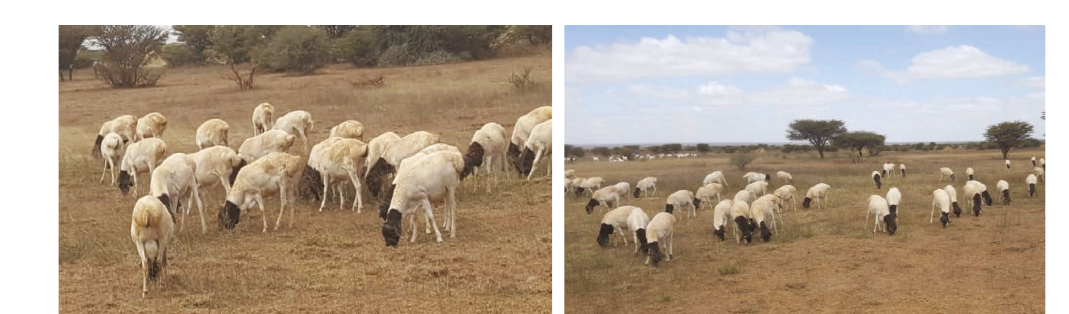
Figure 1: Flock of Blackhead Somali sheep (blackhead with a white